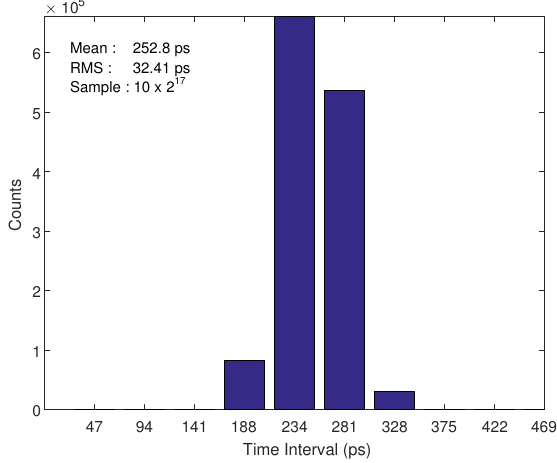
Figure 10. Measurements of constant delay for the proposed